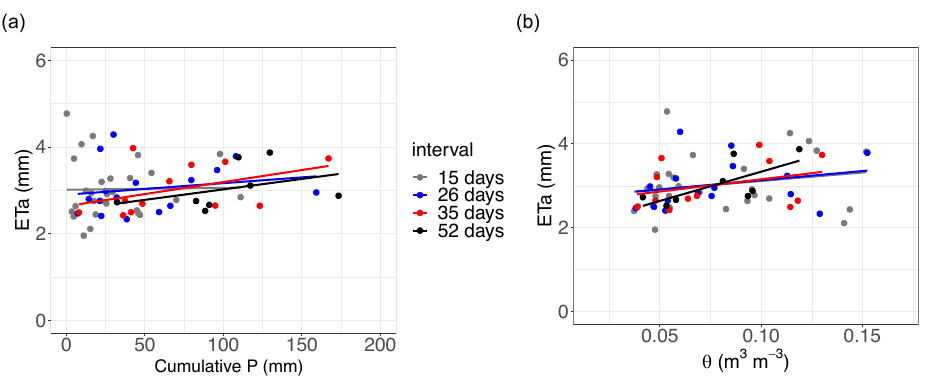
Figure A8. ( a ) Actual evapotranspiration (ETa) versus cumulative precipitation (cumulative P ) considering 15, 36, 35 and 53 days periods. ( b ) Actual evapotranspiration (ETa) versus average shallow soil water content ( θ , 10–20 cm of depth) considering 15, 36, 35 and 52 days periods. None of the regressions is